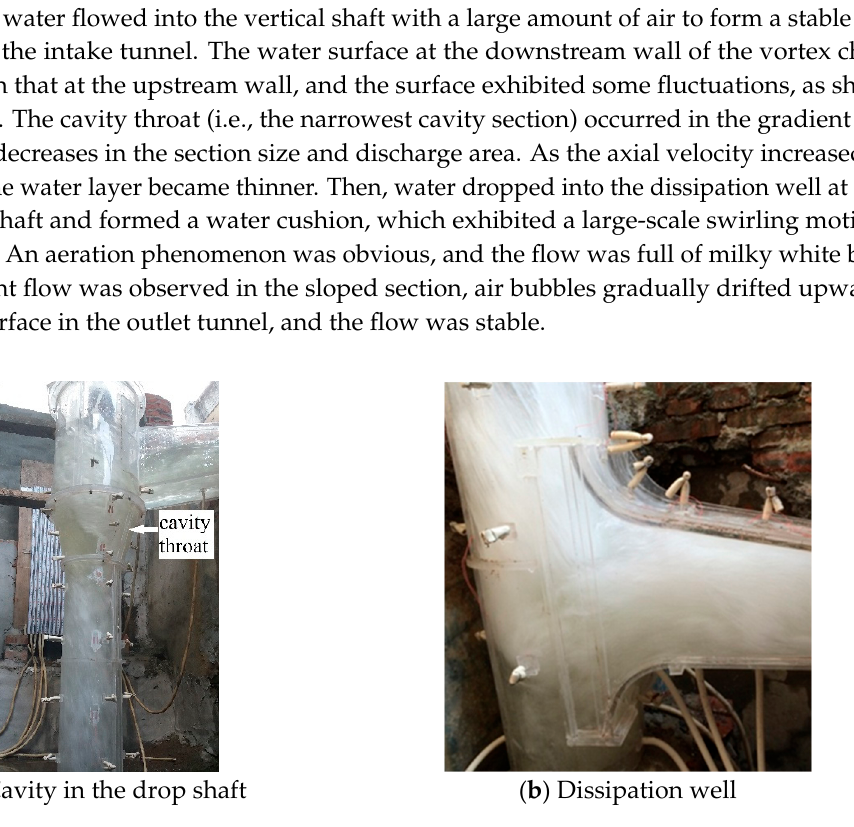
Figure 6. Flow conditions in the experiment (P = 0.1%).